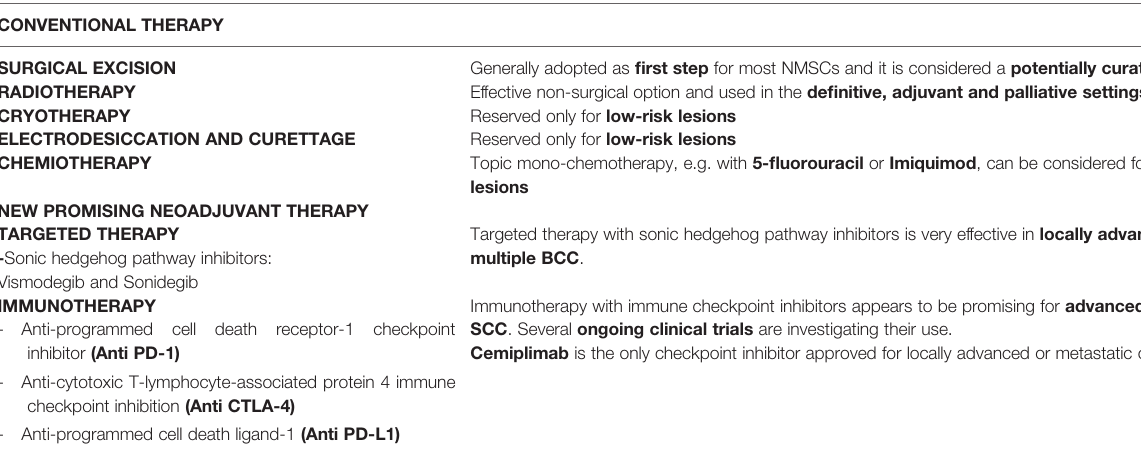
TABLE 3 | Conventional and New promising neoadjuvant